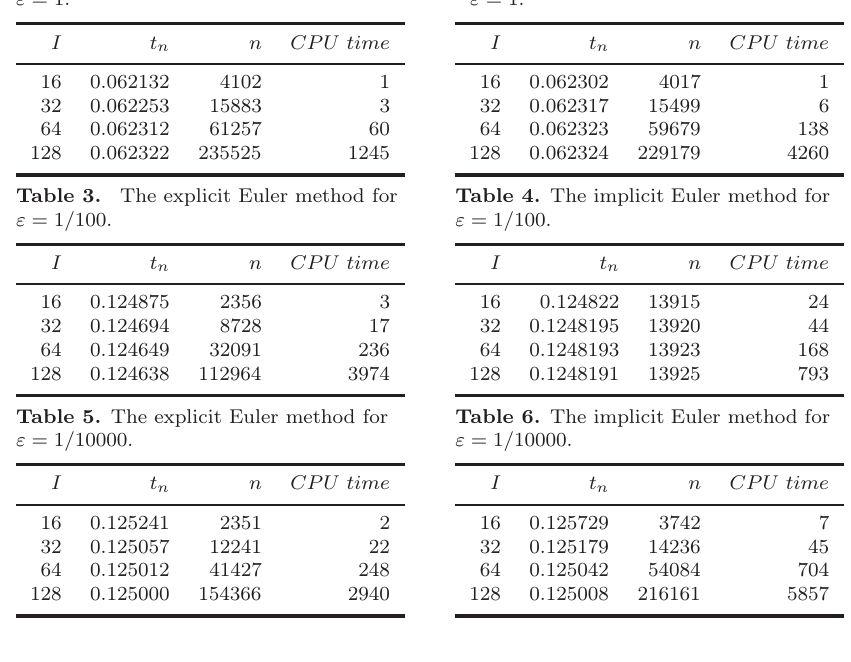
Table 1. The explicit Euler method for ε = 1 .